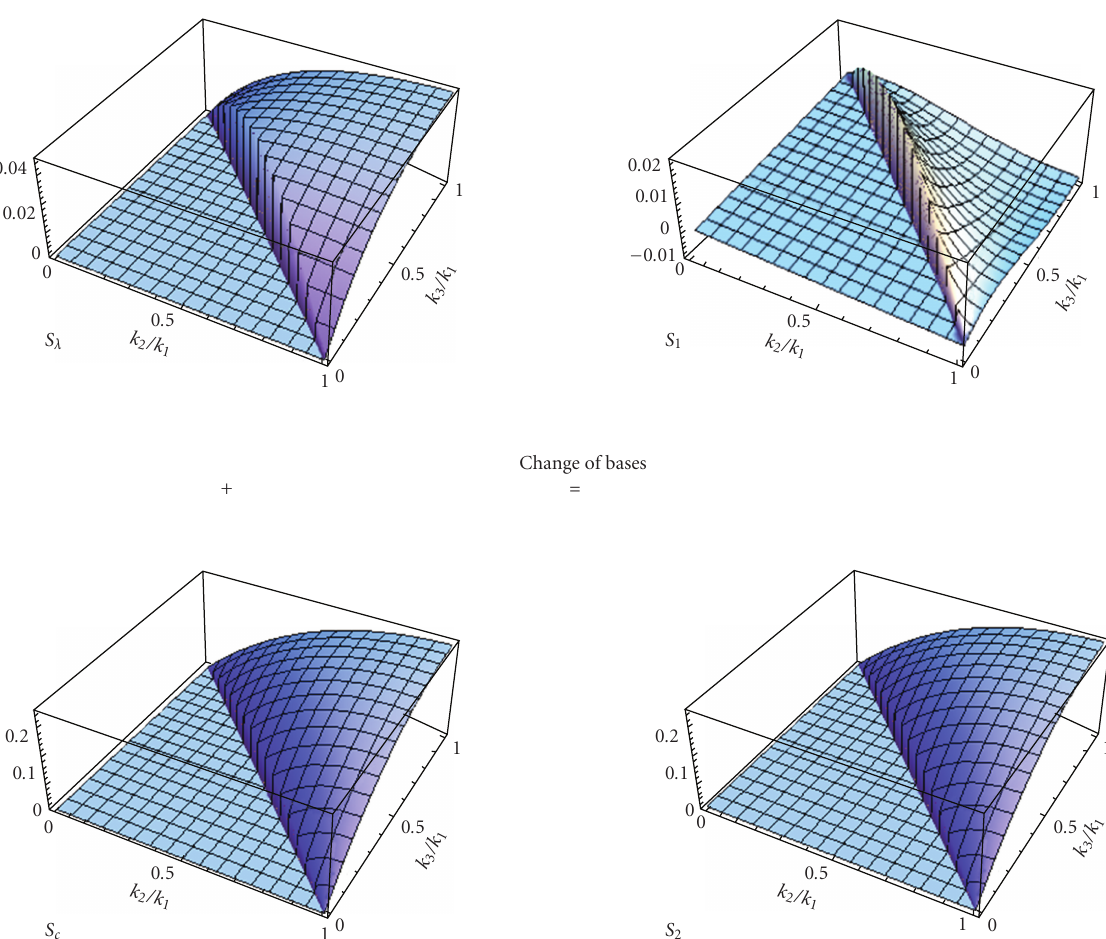
Figure 19: Orthogonalization of two shapes in Section 6.1 (Figures 3 and 4) through a change of bases, c λ S λ + c c S c = c 1 S 1 + c 2 S 2 .